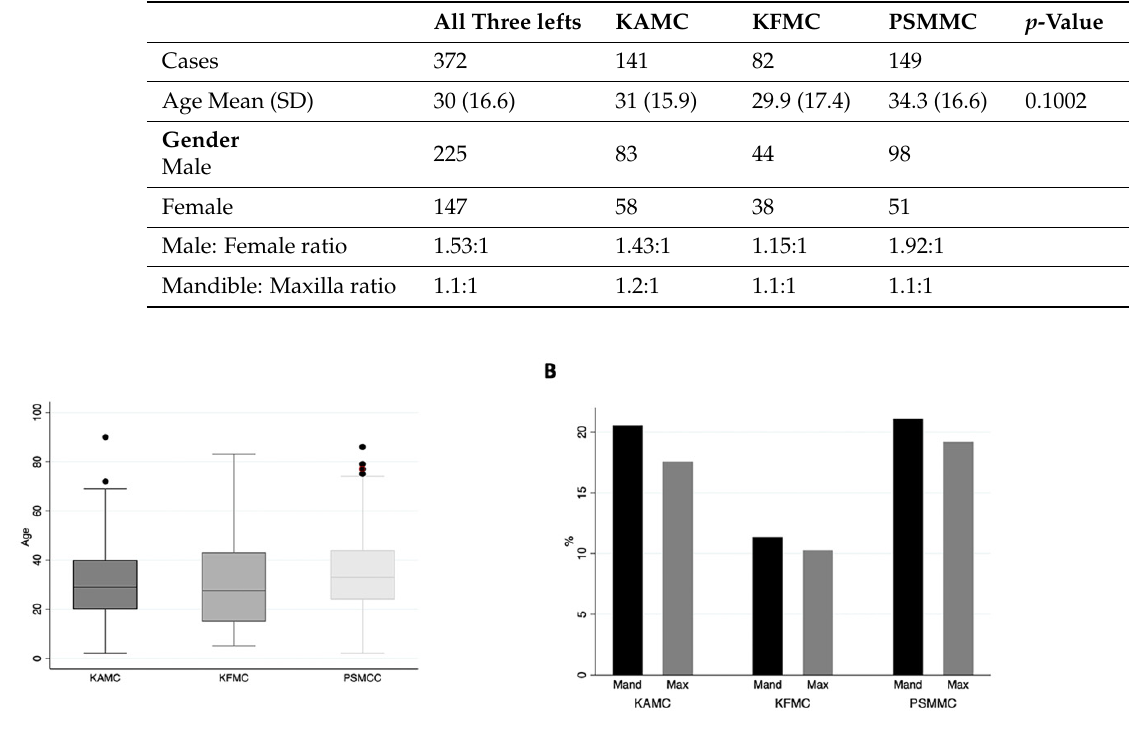
Table 4. Summary of the clinicopathological features of each odontogenic cyst. Number of Case